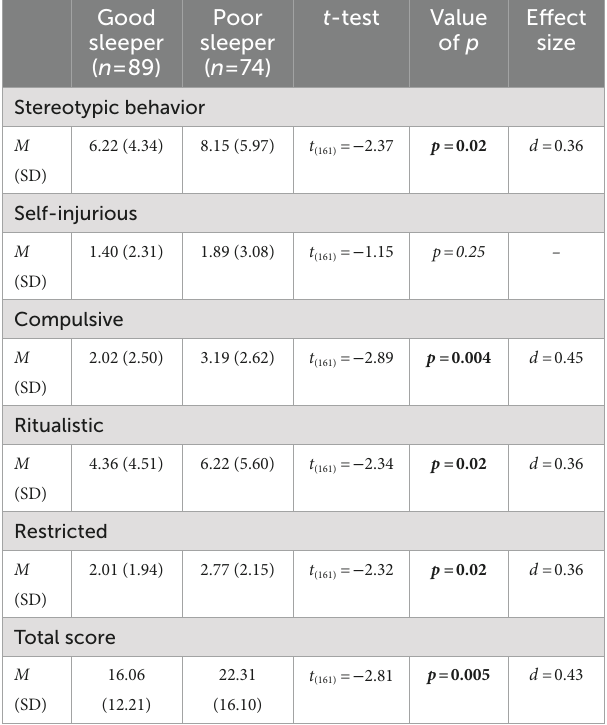
TABLE 5 Logistic regression model of having one or more psychiatric comorbidities.